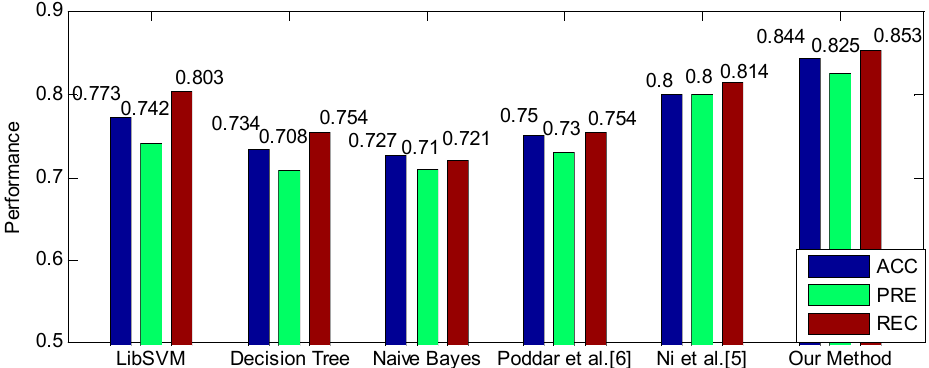
Figure 6. The performance comparison between the proposed method and baseline methods.